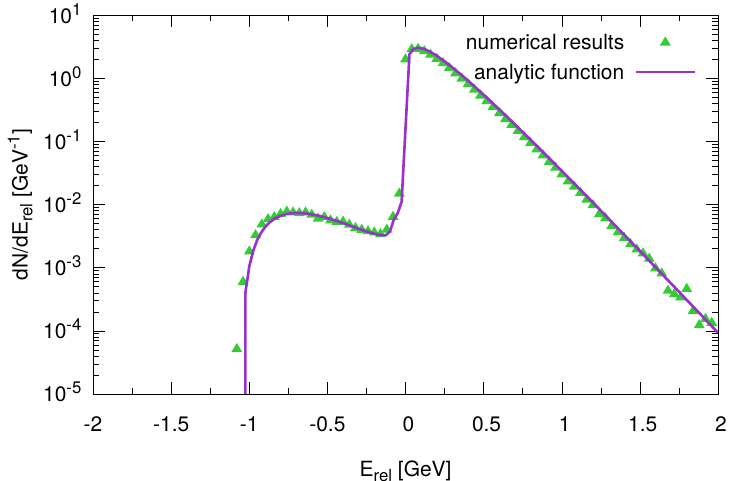
Figure 3. Pair-energy distribution at equilibrium. The simulation is done assuming a cubic box with boxsize 8fm at a temperature of T =